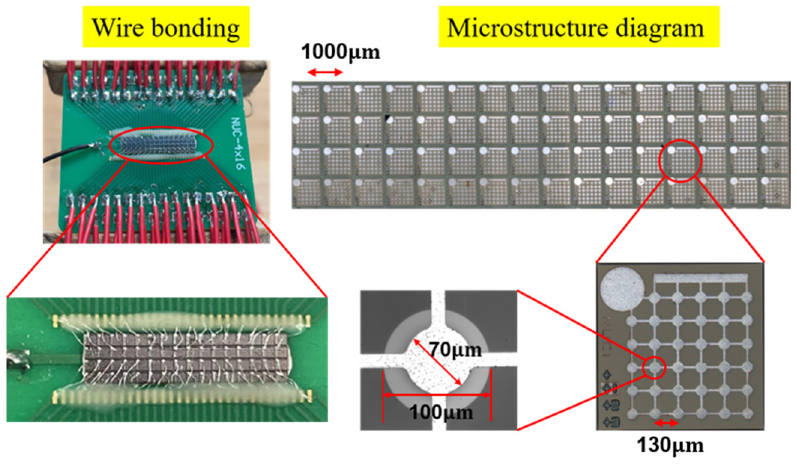
Figure 6. Schematics and images of the resulted transducer. The CMUT array is fixed on the circuit board by Ag–Al wire bonding. The partially enlarged view displays the internal details of the transducer, as well as the stacked structure of the electrode and the cavity.